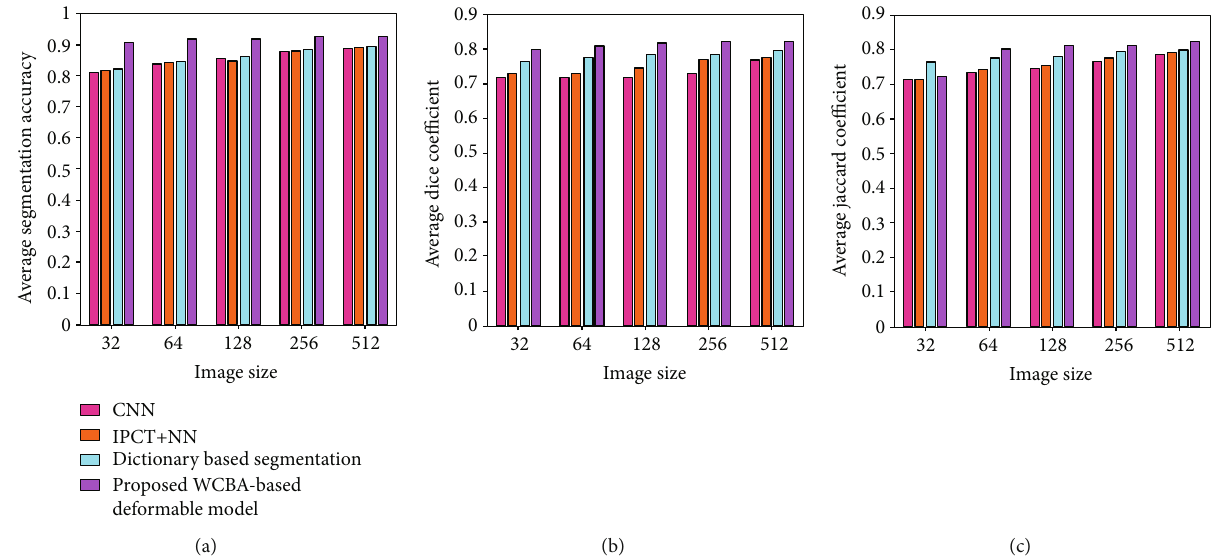
Figure 5: Comparative analysis of the proposed method for the cluster size 5: (a) average segmentation accuracy, (b) average Dice coe ffi cient, and (c) average Jaccard coe ffi